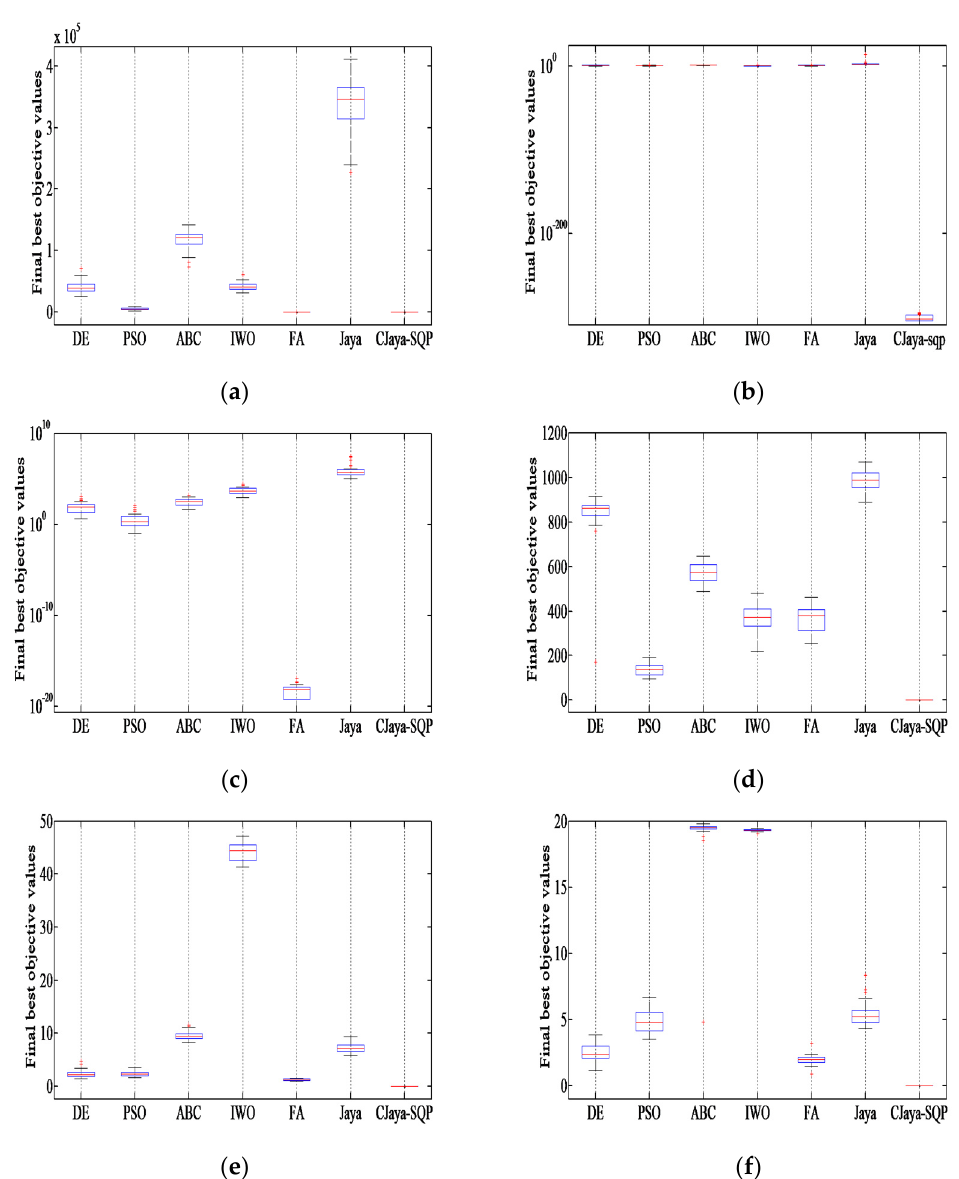
Figure 12. Boxplot of final best objective values obtained by different algorithms over 30 runs on the 100-dimensional rotated problems: ( a ) f 10 Rotated Schwefel 1.2; ( b ) f 11 Rotated Schwefel 2.22; ( c ) f 12 Rotated Zakharov; ( d ) f 14 Rotated Rastrigin; ( e ) f 15 Rotated Salomon; and ( f ) f 16 Rotated Ackley.